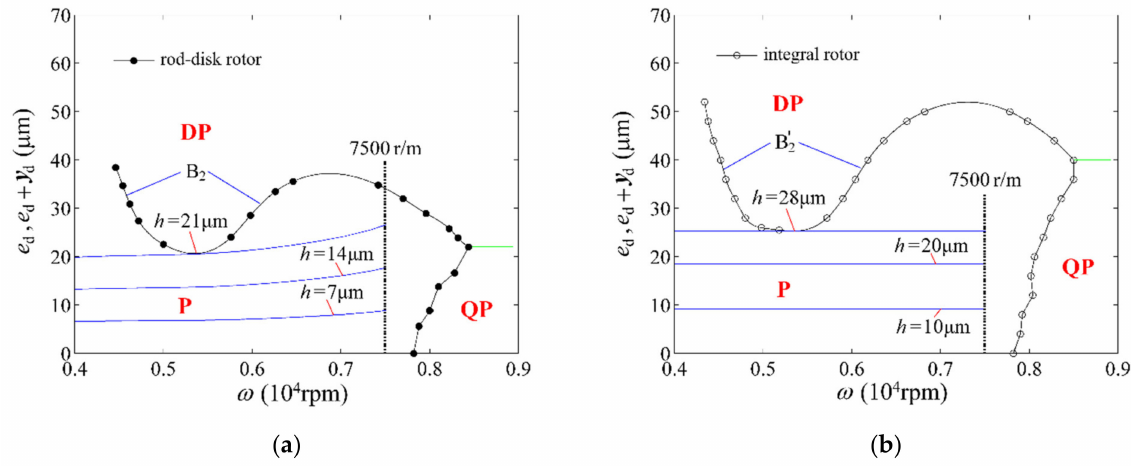
Figure 13. Maximum allowable inner misalignment which is obtained from the global stability areas for the flawed rod–disk and integral rotors. ( a ) Maximum allowable inner misalignment for the flawed rod–disk rotor; ( b ) Maximum allowable inner misalignment for the flawed integral rotor.